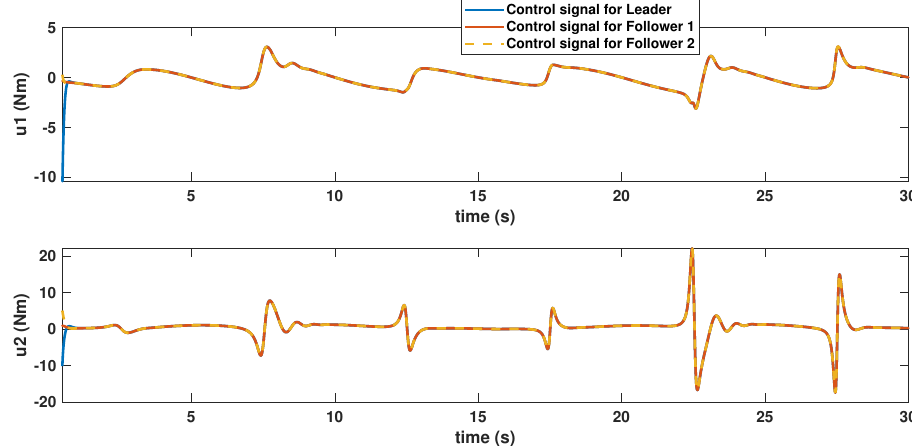
Figure 16. Path 3: Control